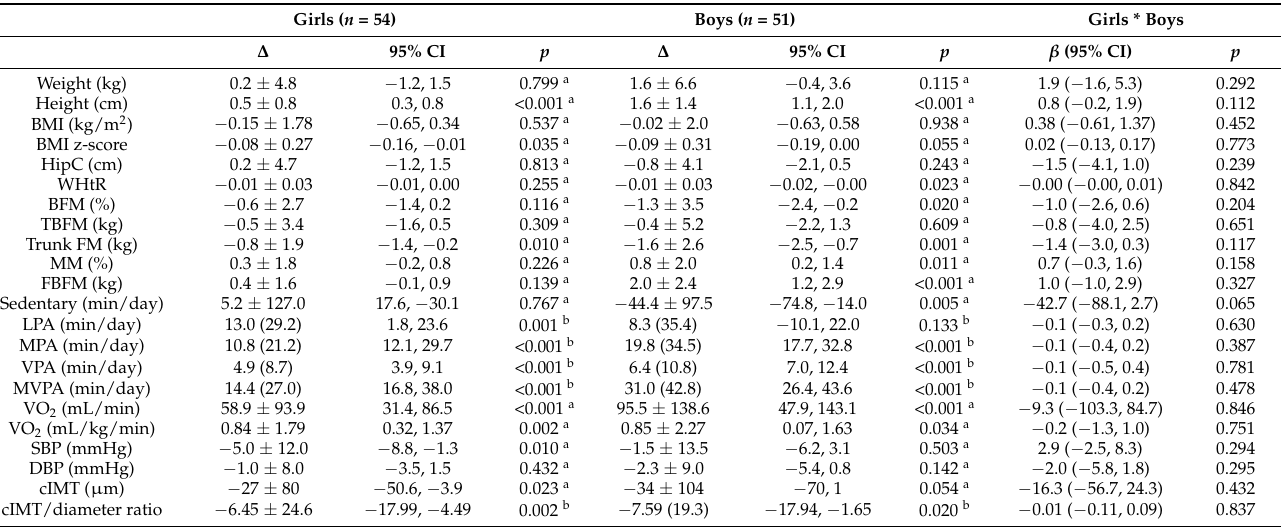
Table 2. Overtime changes from baseline to 6 months by